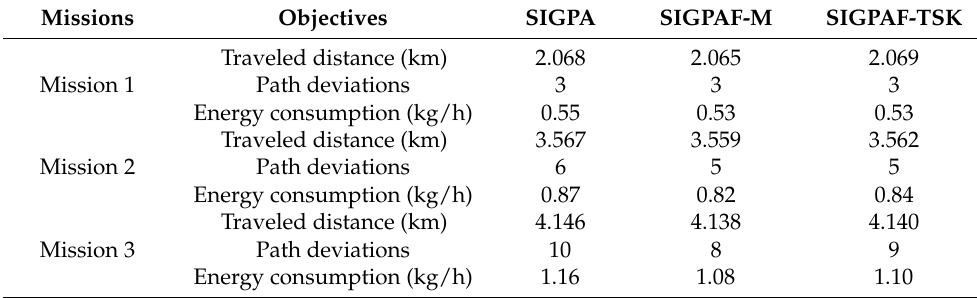
Table 3. Evaluation of SIGPA, SIGPAF-M, and SIGPAF-TSK on the optimality criteria.